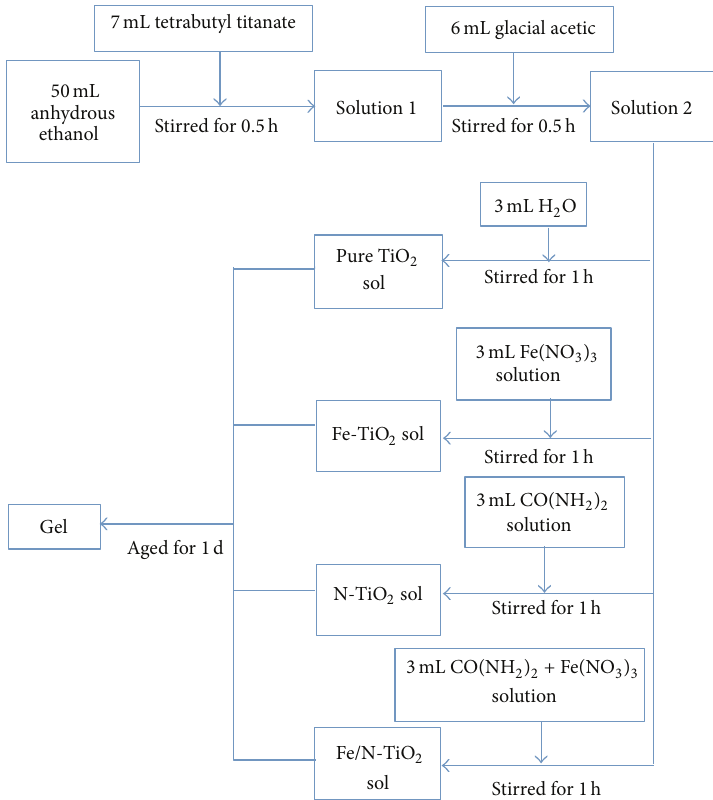
Figure 1: The schematic diagram of preparing procedures of gels.